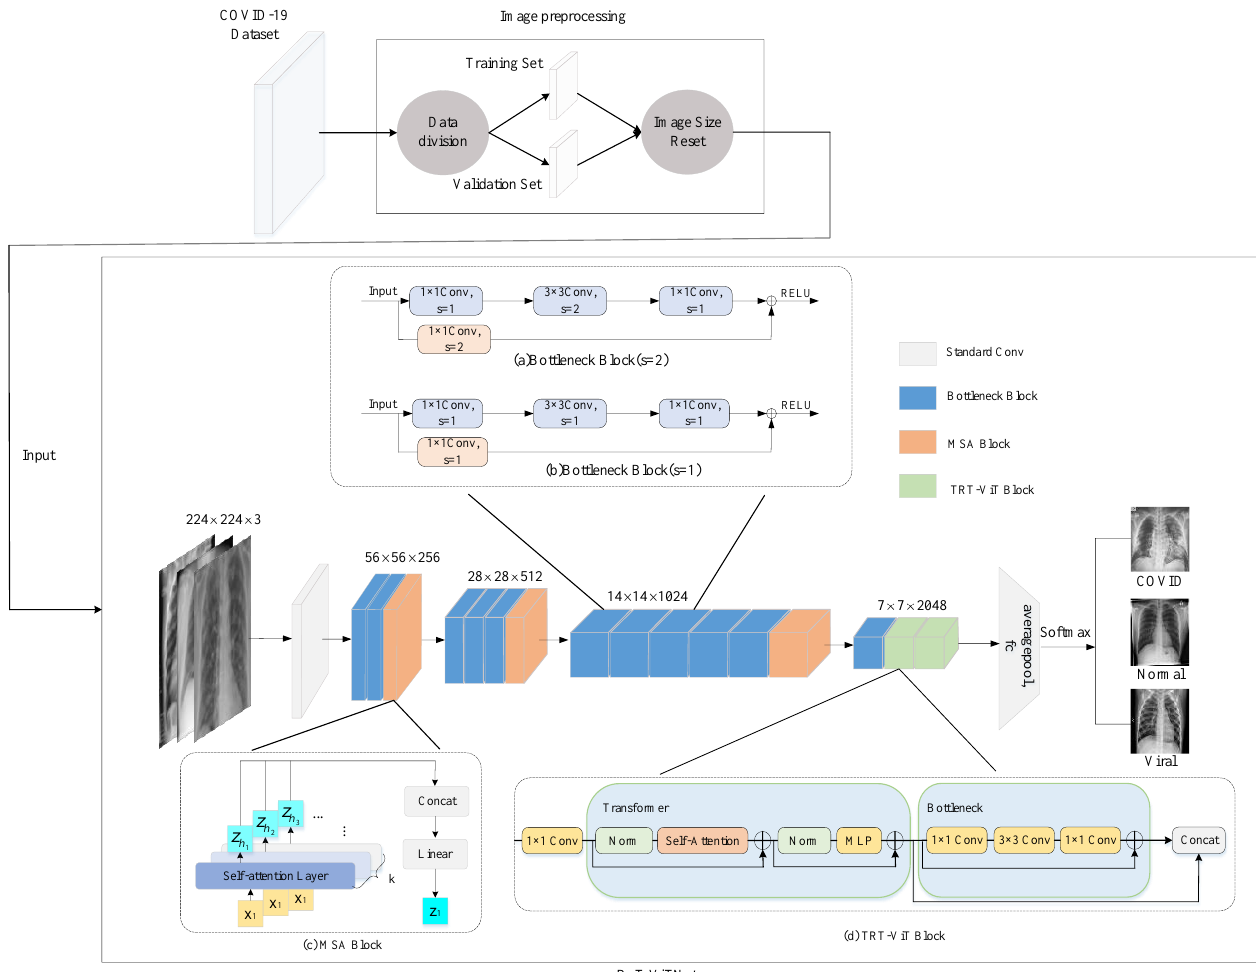
Figure 1. The whole structure of the BoT-ViTNet model. (a) Bottleneck Block(s = 2); (b) Bottleneck Block(s = 1); (c) MSA Block; (d) TRT-ViT Table 1. The structure details and specific parameters of the BoT-ViTNet model.